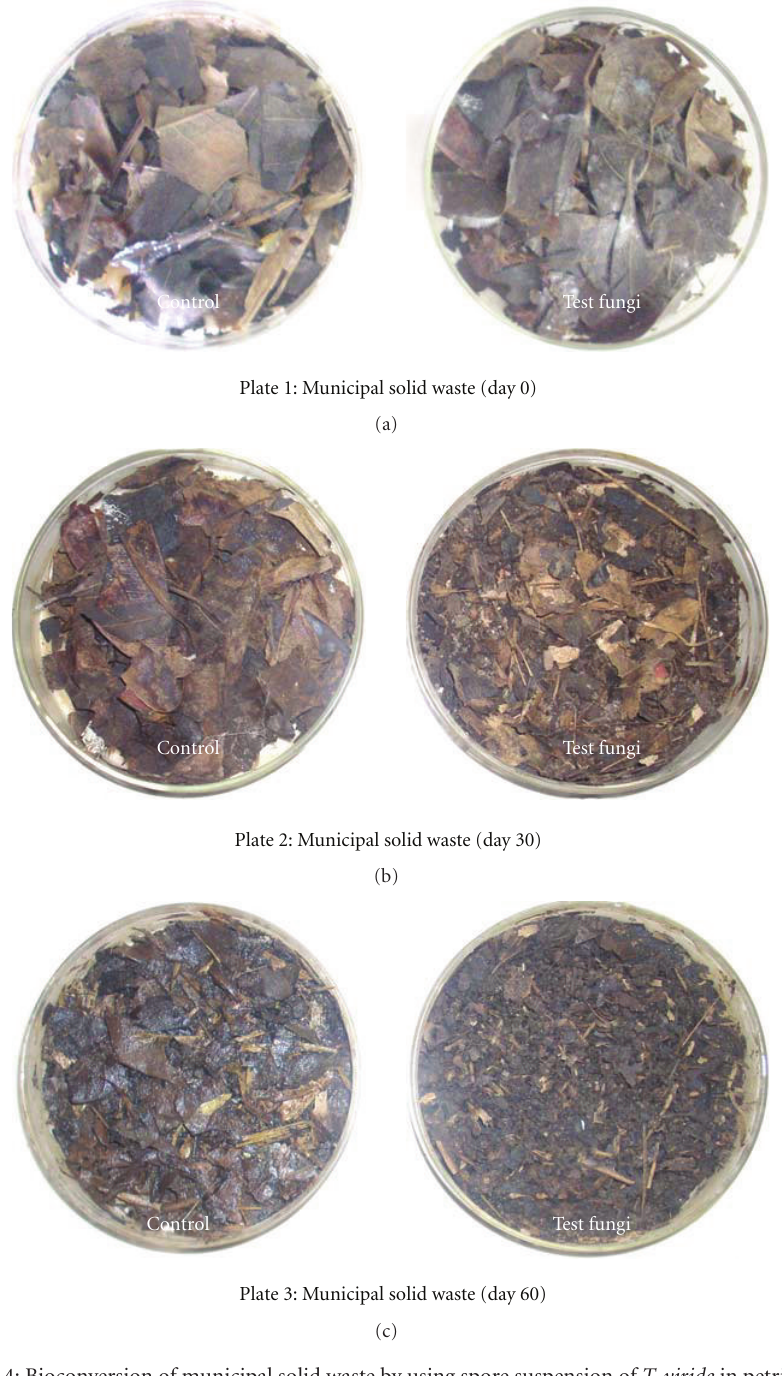
black color indicated its maturity. In the case of the